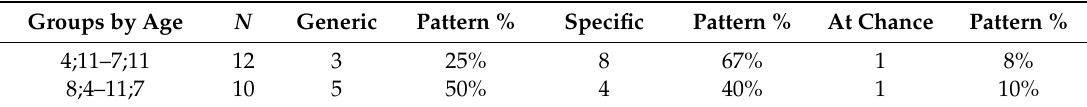
Table 2. Definite NPs: Individual subject patterns by age.